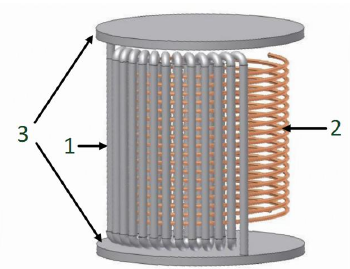
Figure 7. Diagram of the coiled-core induction sensor. (1) shows the ferromagnetic coil, (2) the conductive coil and (3) the ferromag- netic